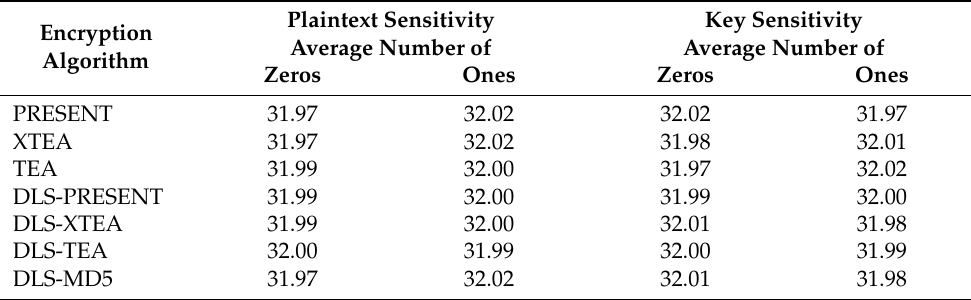
Table 6. Average number of zeros and ones in 64-bit ciphertext block when there is a single-bit change in plaintext (plaintext sensitivity) and key (key